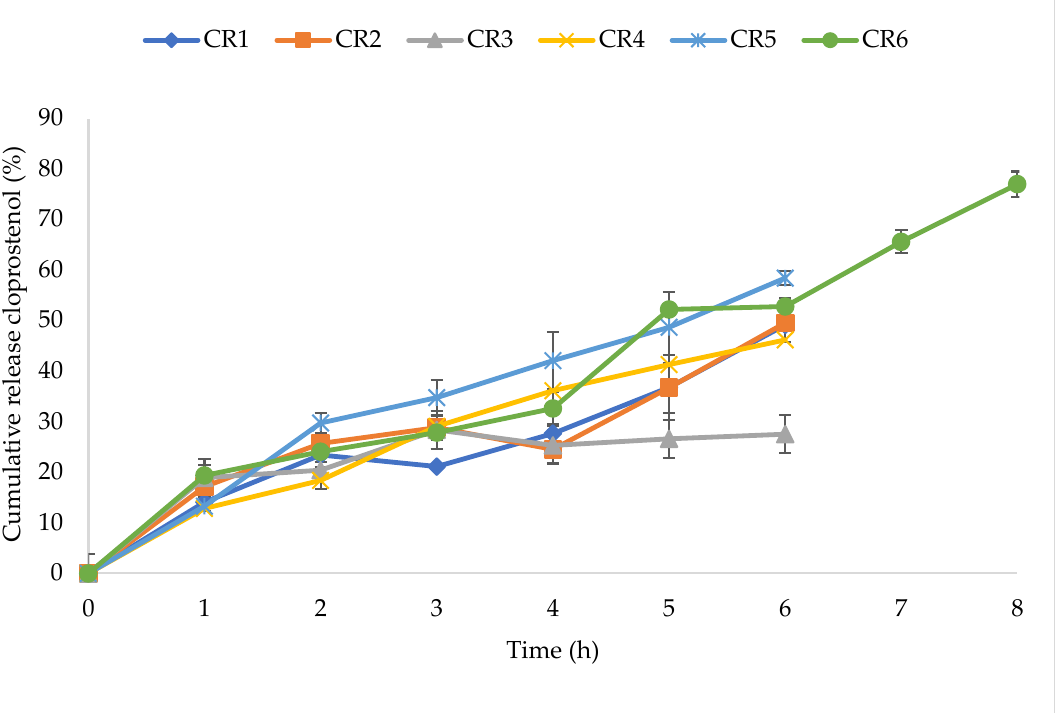
Figure 6. In vitro release profiles of cloprostenol CR NVDDS formulations. Each data point is the mean ± standard deviation of the triplicate. Formulation CR6 displayed favourable release and was assessed over an eight-hour time period.